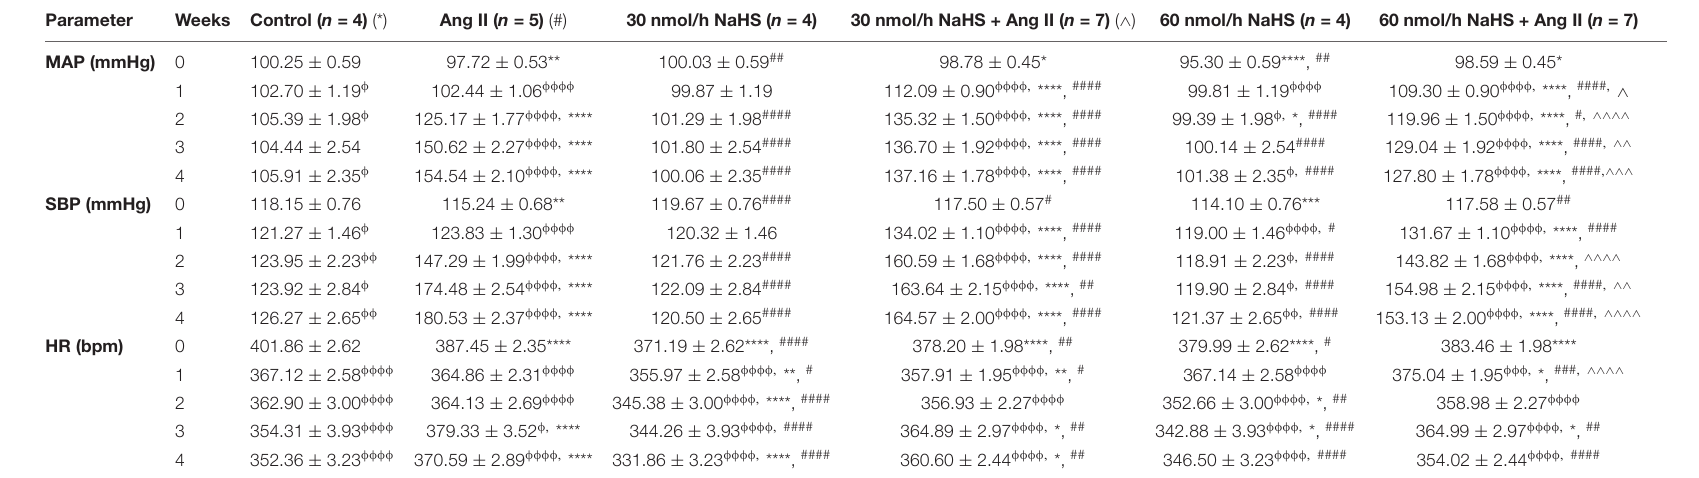
TABLE 1 | Changes in blood pressure and heart rate in response to subcutaneous Angiotensin II and intracerebroventricular NaHS infusion.